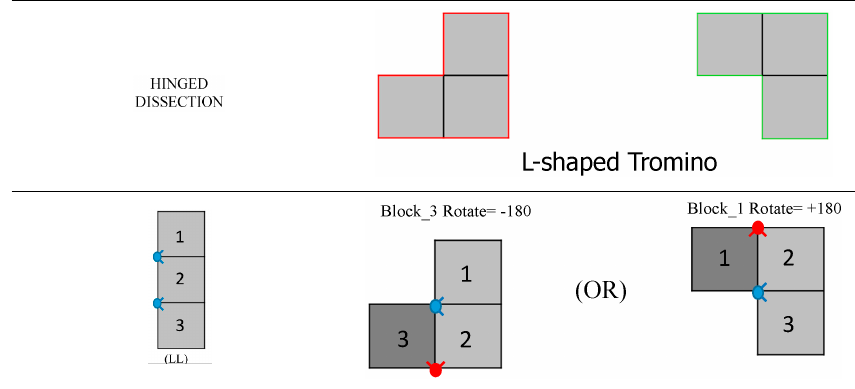
Table 1. LL hinged points of hTromo robot. LL : Left Left.